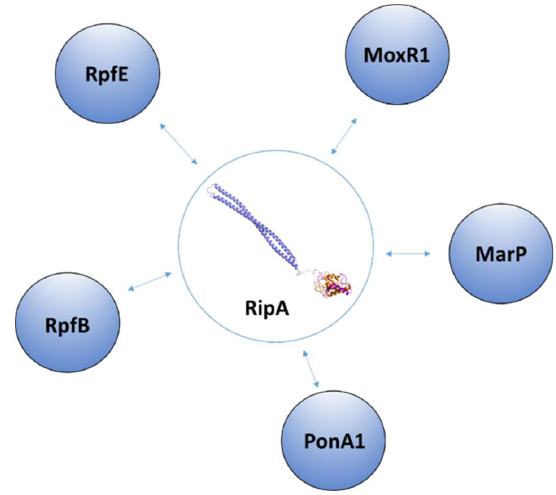
Figure 9. Interacting partners of RipA.